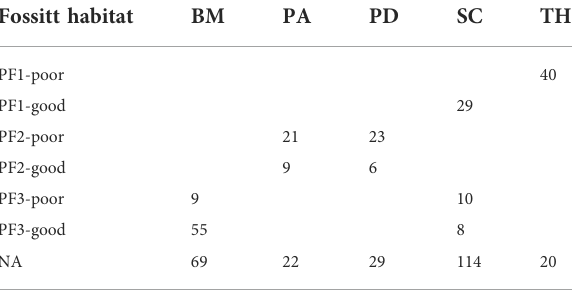
TABLE 2 Numbers of monitoring sites in each fen classi fi ed into good or poor ecological condition. Fossitt habitat